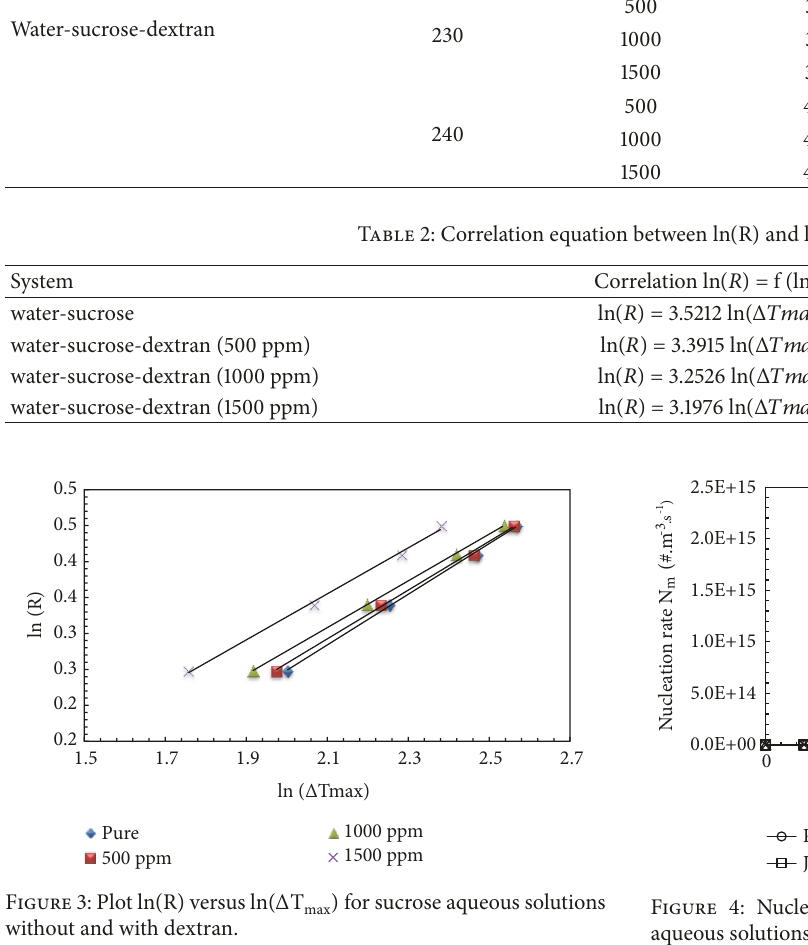
, and MSZW for aqueous sucrose solutions of different concentrations max